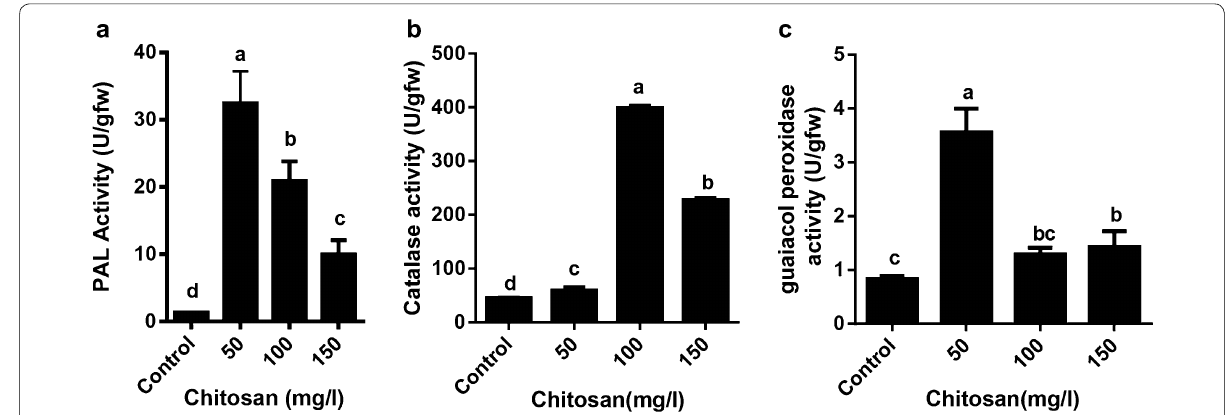
Fig. 3 Effect of chitosan levels on PAL ( a ), CAT ( b ) and GOP ( c ) activities of Melissa officinalis shoot cultures. Each value is expressed as mean standard deviation. Differences were significant at p < 0.05 level (one-way ANOVA followed by LSD ±